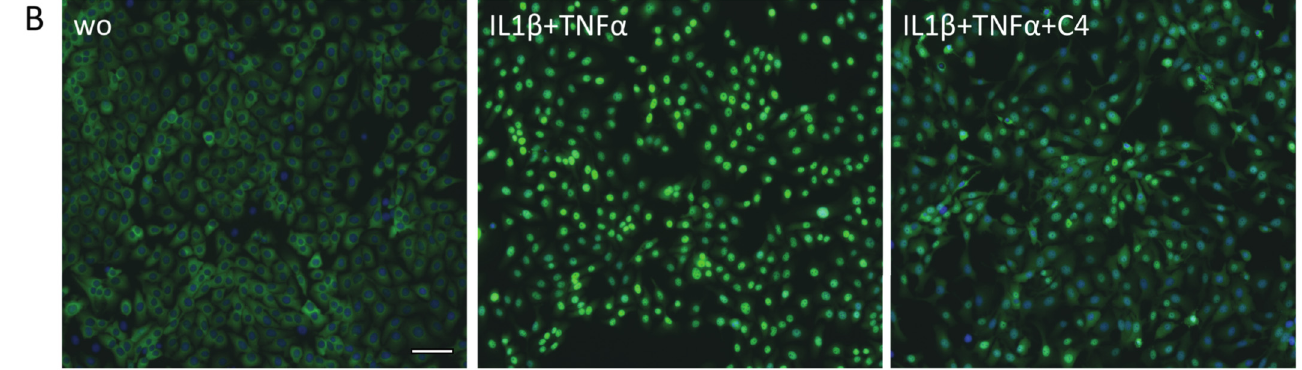
Figure 7. Butyrate decreased the nuclear translocation of p65 in gingival fibroblasts and HSC2 cells. ( A ) Gingival fibroblasts and ( B ) HSC2 oral epithelial cells were exposed to 10 ng/mL IL1 β and TNF α with and without 10 mM butyrate (C4). Immunofluorescence of nuclear translocation of NF- κ B p65 into the nucleus is indicated by green staining. Cells with no or low p65 nuclear translocation appear blue. “wo” means “without” and represents unstimulated cells. Scale bar is 100 µm.